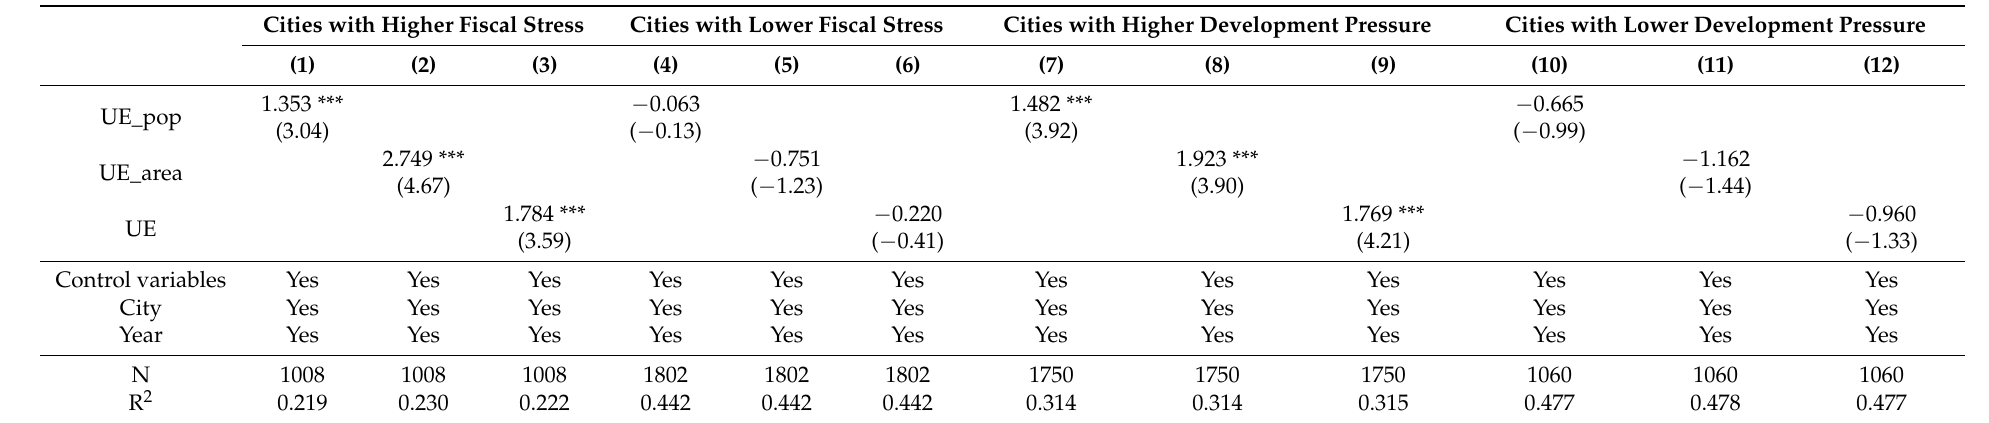
Table 6. Regression results of heterogeneity of fiscal stress and development